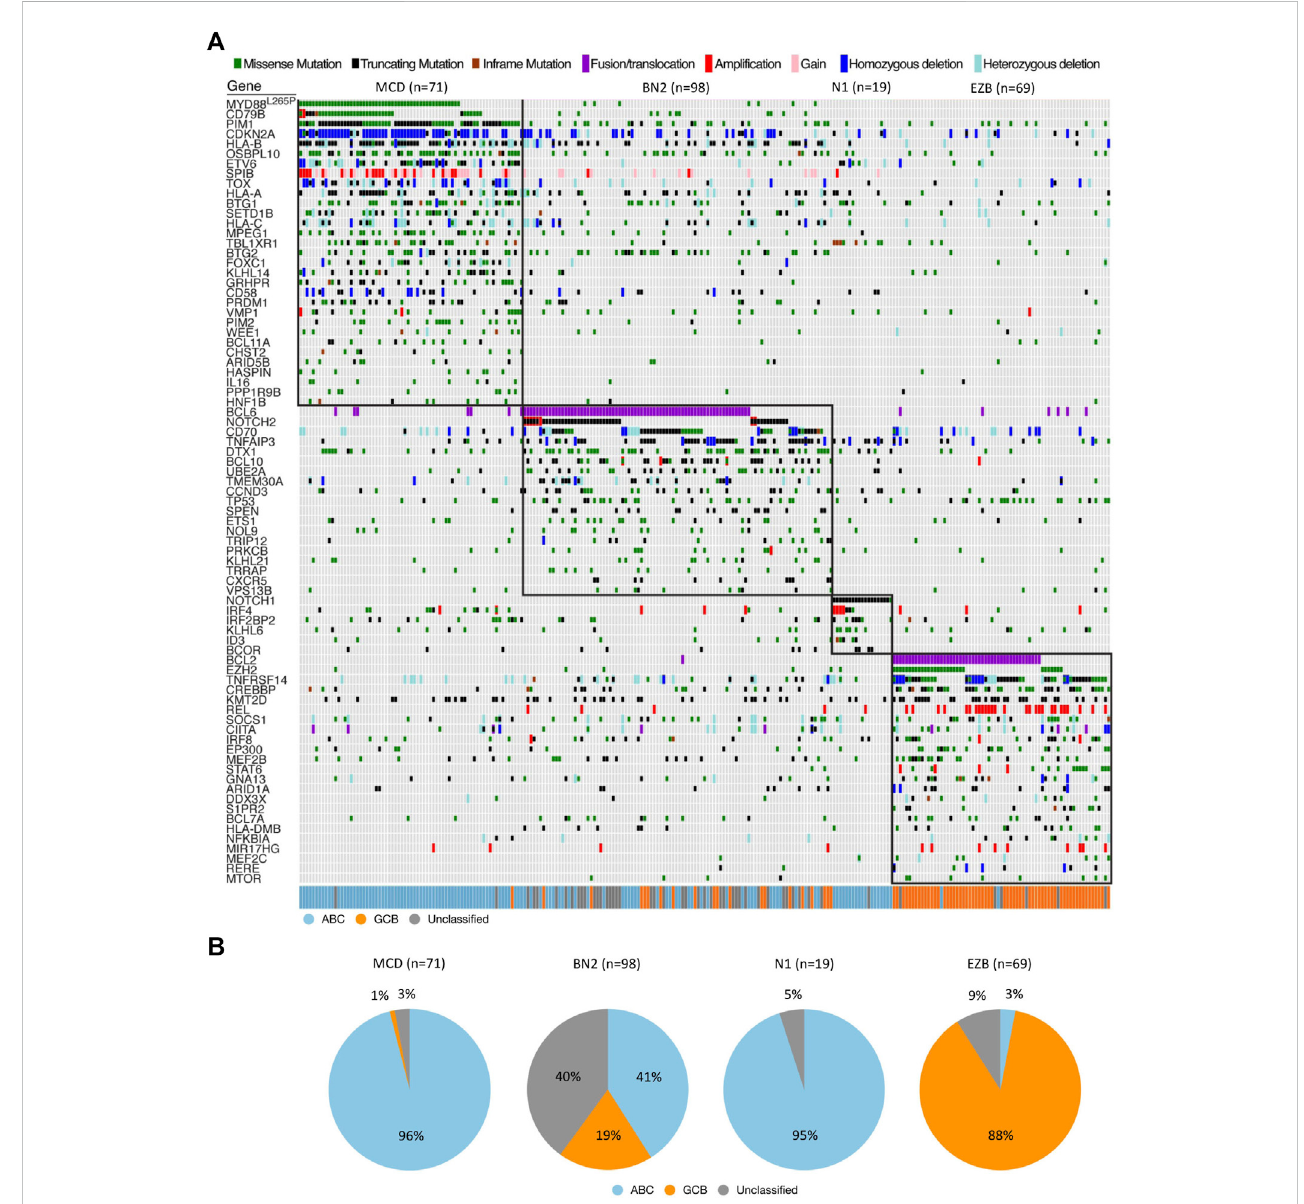
FIGURE 1 Genetic features of DLBCL. (A) Landscape of DLBCL genetic subtypes based on genetic alteration. Relationship between genetic subtypes (e.g., MCD, BN2,N1,EZB)andgeneexpressionsubtypes(e.g.,ABC,GCB,Unclassi fi ed)isalsoshown. (B) Distributionofgeneexpressionsubtypeswithingeneticsubtypes. AlldatawereextractedfromtheresultsofthewholeexomesequenceandRNA-seqpublishedbySchmitzetal.(2018).AdaptedwithpermissionfromSchmitz et al. (2018). Copyright 2018, Massachusetts Medical